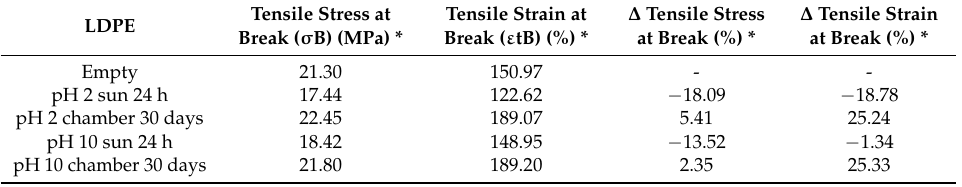
Table 2. Results obtained by mechanical analyses for low-density polyethylene (LDPE) containers. LDPE